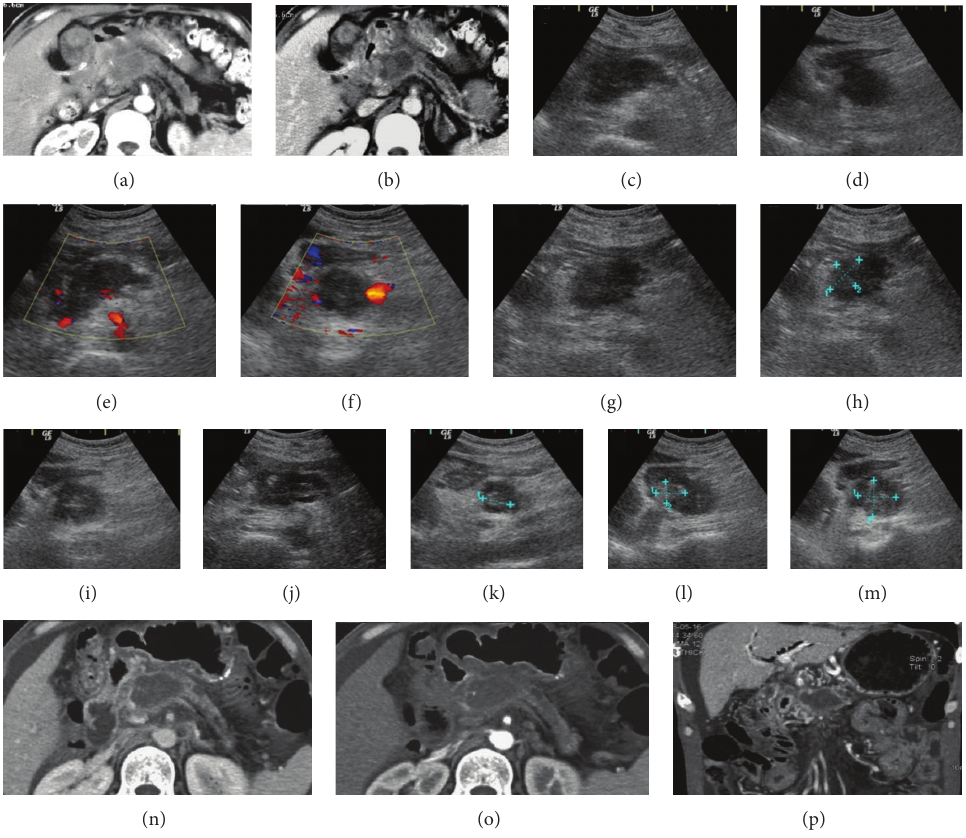
Figure 3: A 53-year-old man with about 5.0 × 2.6 × 2.2 cm pancreatic body carcinoma. The pre-HIFU enhanced CT showed uneven low- density lesions in pancreatic body with mild enhancement in parenchyma in arterial phase (a) and venous phase (b) and liquefaction necrosis. Ultrasound showed hypoechoic lesions ((c) cross section and (d) longitudinal section) with clear boundary, internal heterogeneous echo, and small blood flow signal from around the tumor ((e) cross section and (f) longitudinal section). In the 2nd treatment, ultrasound showed increase of ultrasound reflection intensity within 2.8 × 1.9 cm on the right lesions with unclear boundary ((g), (h)). In the 3rd treatment, ultrasound reflection intensity gradually increased with unclear boundary ((i) and (j)). In the 4th treatment, longitudinal ultrasound on the left lesions showed significant increase of ultrasound reflection intensity (k). In the 6th treatment, longitudinal ultrasonography showed increased reflection intensity in the upper area of the lesions ( 2.2 × 1.7 cm) (l). In the 8th treatment, ultrasound showed significant increase of ultrasound reflection intensity (m). A month later, enhanced CT ((n) arterial phase, (o) venous phase, and (p) coronal-section) showed no internal significant enhancement, but marginal ring enhancement and tumor ablation ratio over 70%. Patient ascites increased due to